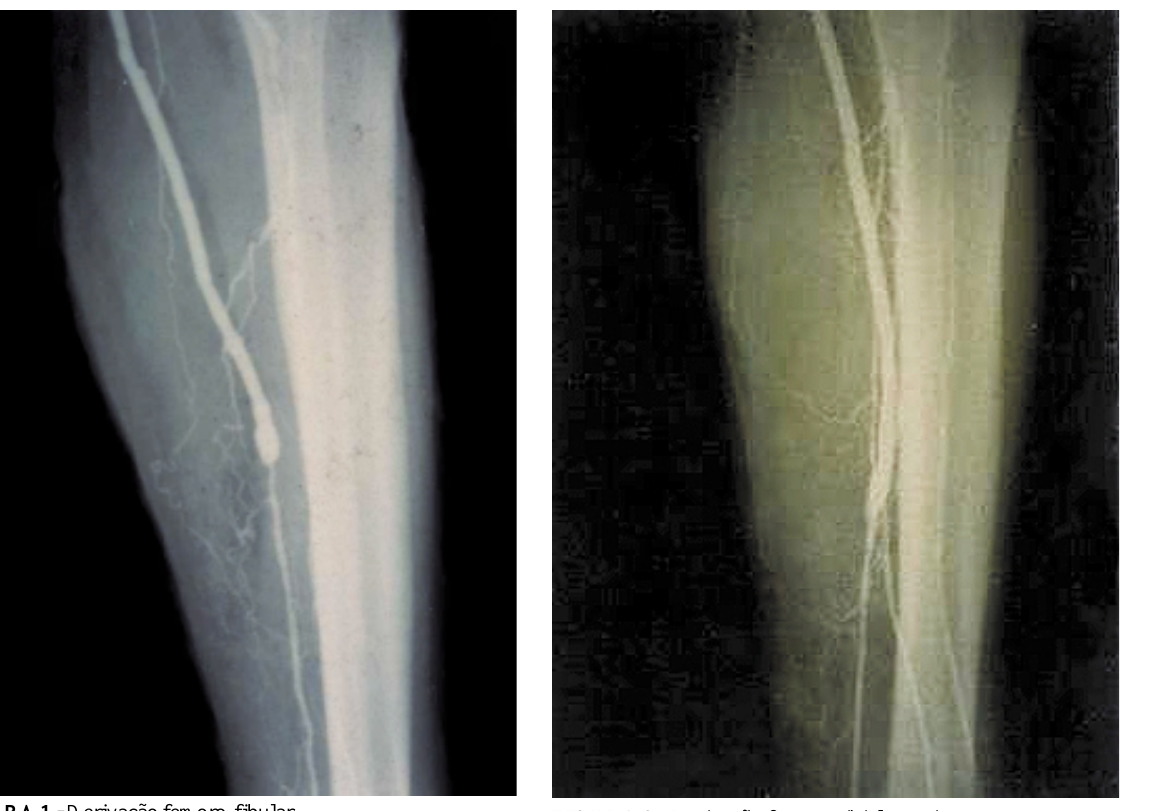
FIGURA 3 - Derivação femoro-tibial